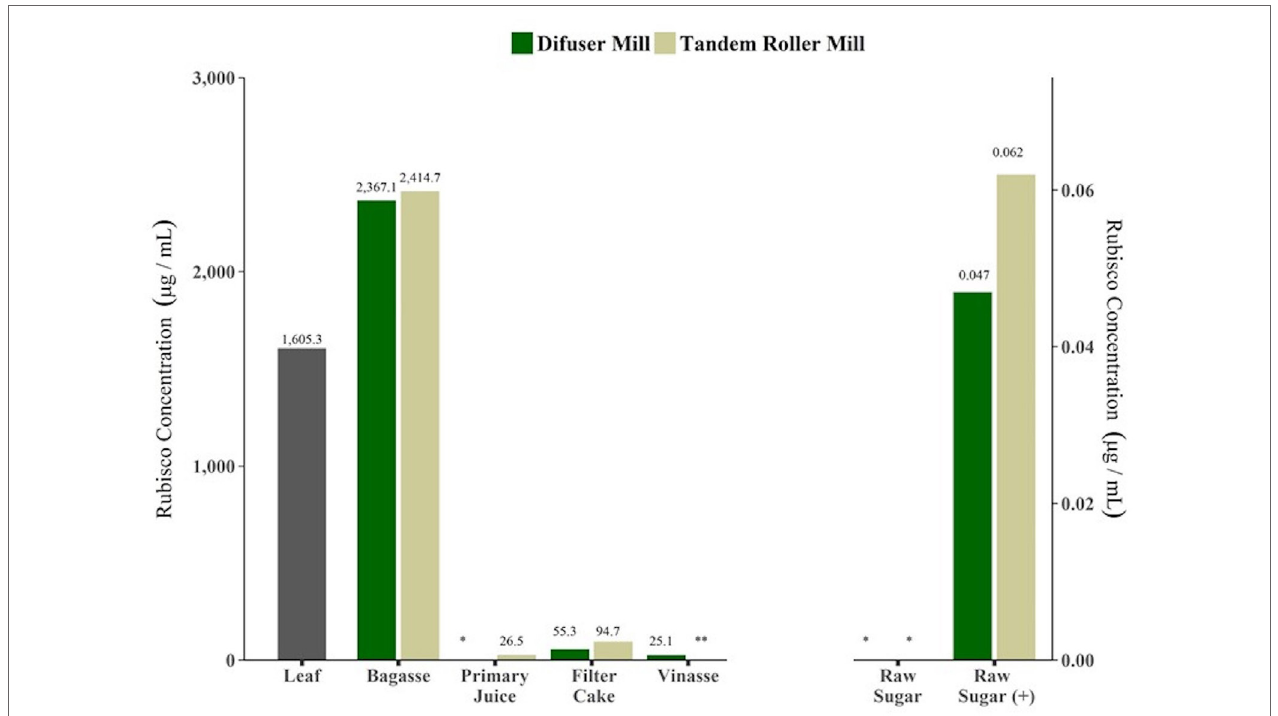
FigUre 3 | Ribulose-1,5-bisphosphate carboxylase/oxygenase (RuBisCO) protein detection in by product samples collected during industrial process for sugar and alcohol production, from two types of sugarcane mills, by ELISA assay. Single batch results ( n = 1). *: below limit of detection (LOD). **: not analyzed. Raw sugar ( + ): samples of raw sugar spiked with 10 µg of total protein before extraction.